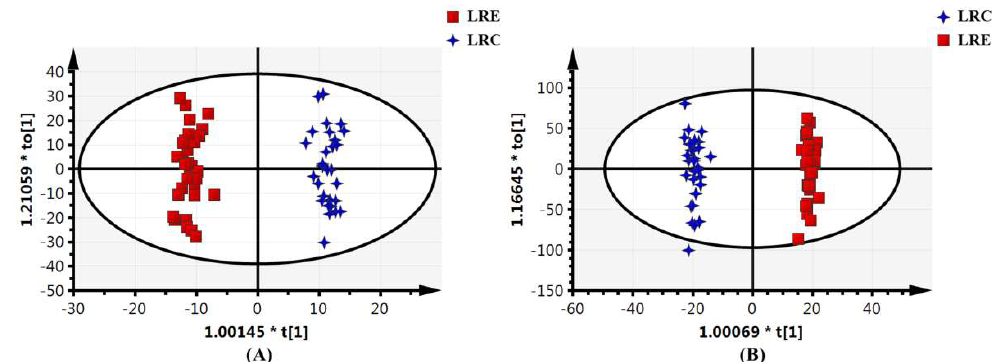
Figure 2. Scores plot from the orthogonal projections to latent structures discriminant analysis of the global metabolome in the LRC and LRE group ( A ) in the positive ionization mode; ( B ) in the negative ionization mode. Blue crosses represent LRC group. Red squares represent LRE group. Their spatial distribution reveals the variations of the metabolic profiles between the two groups. The two groups exhibit a clear separation, indicating that there are distinct differences in the global metabolic profiles between the two groups. LRC, centenarians in the longevous region; LRE, elderly people aged 60–70 years in the longevous region. Table 2. The parameters of the OPLS-DA